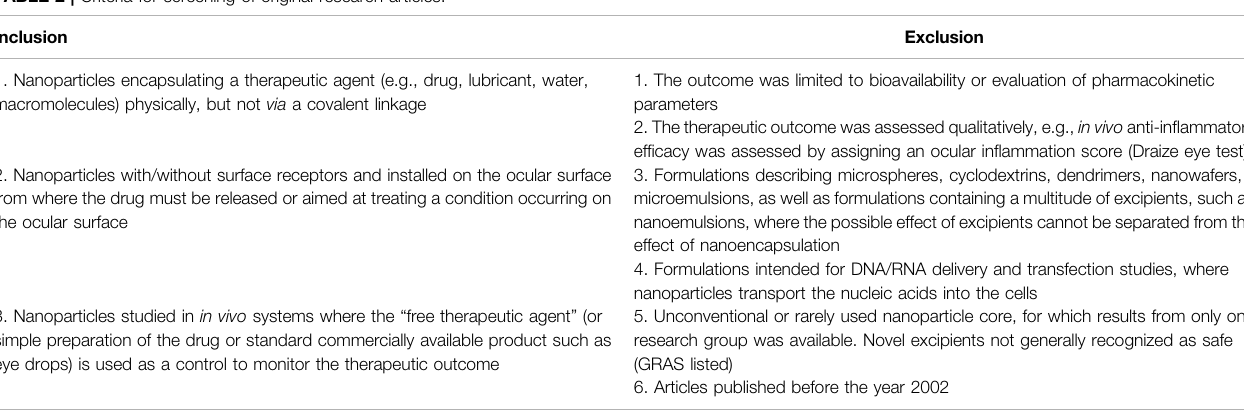
TABLE 2 | Criteria for screening of original research